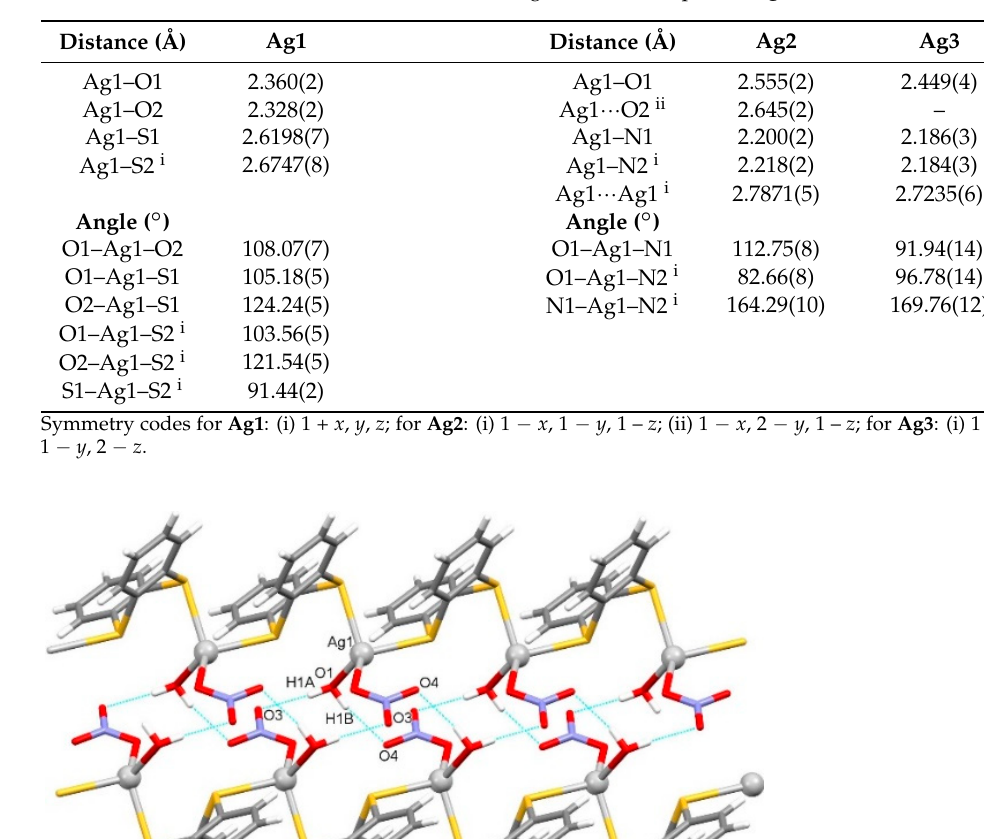
Figure 1. Crystal structures of complexes Ag1 – 3 . Thermal ellipsoids are drawn at the 50% probability level. For Ag3 , only one anion is presented for clarity. Table 1. Selected bond distances (Å) and bond angles ( ◦ ) for complexes Ag1 – 3 .